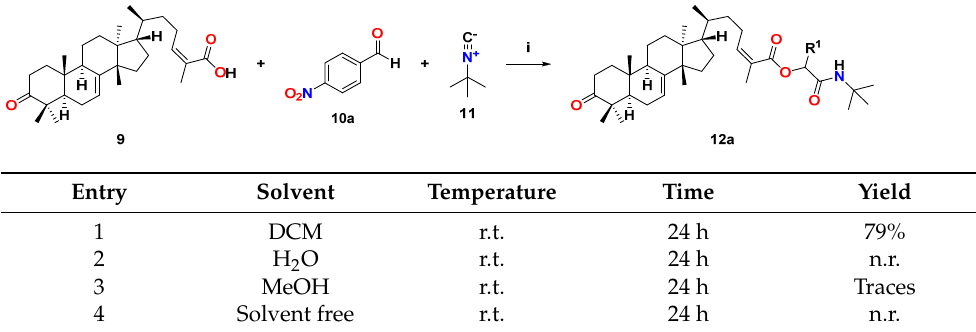
Table 1. Screening conditions for synthesis of α -acyloxycarboxamide 12a .